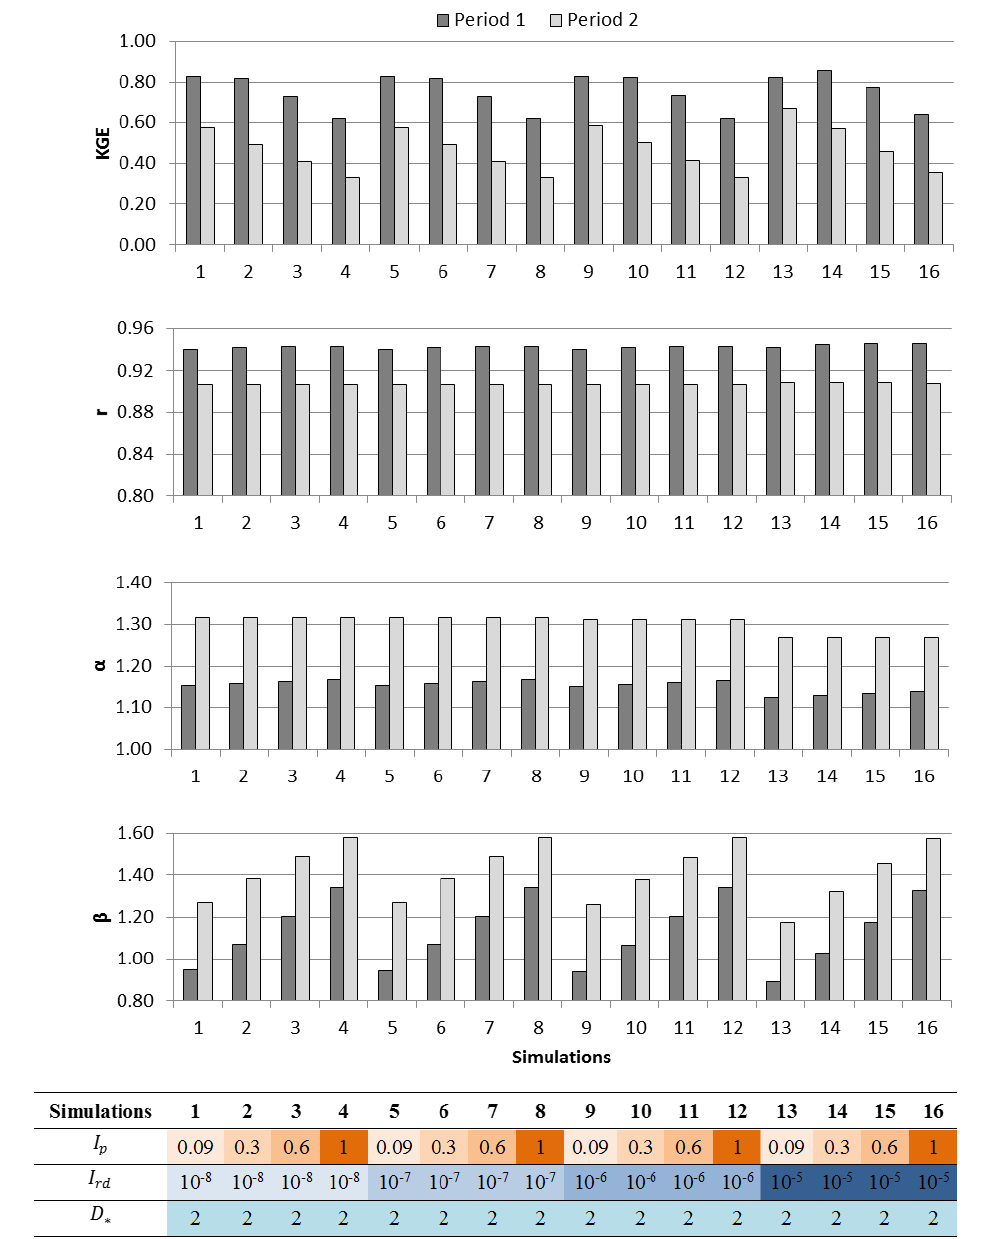
Figure 9. Example of a calculated criterion for the simulation configurations where parameter D ∗ (deep drainage) is limited to 2% and all other parameters allowed to vary. The KGE criterion, the correlation criterion ( r ), the variability criterion ( α ) and the bias ( β) for all 16 simulations and for the first (dark grey) and second (light grey) simulation periods are